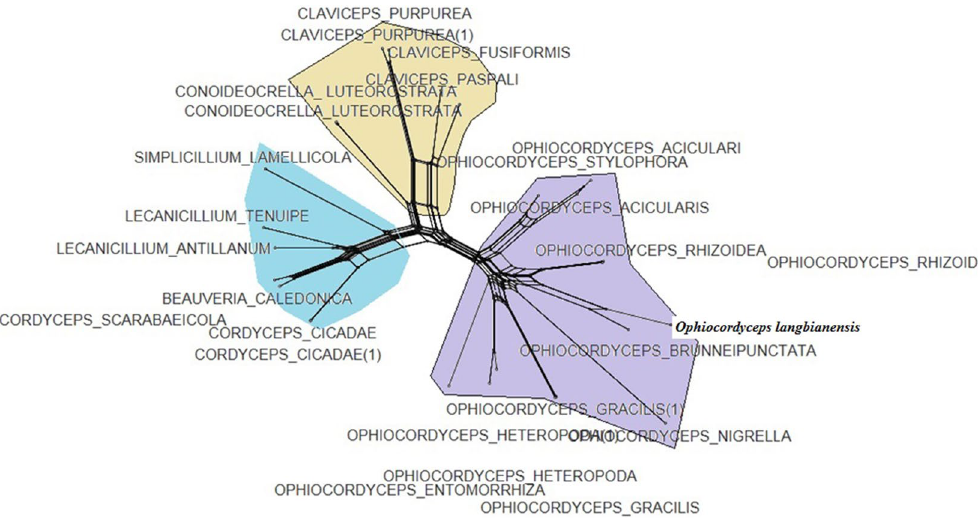
Figure 5. Reconstruction of Neighbor-Net network of DL0017 and its allies.